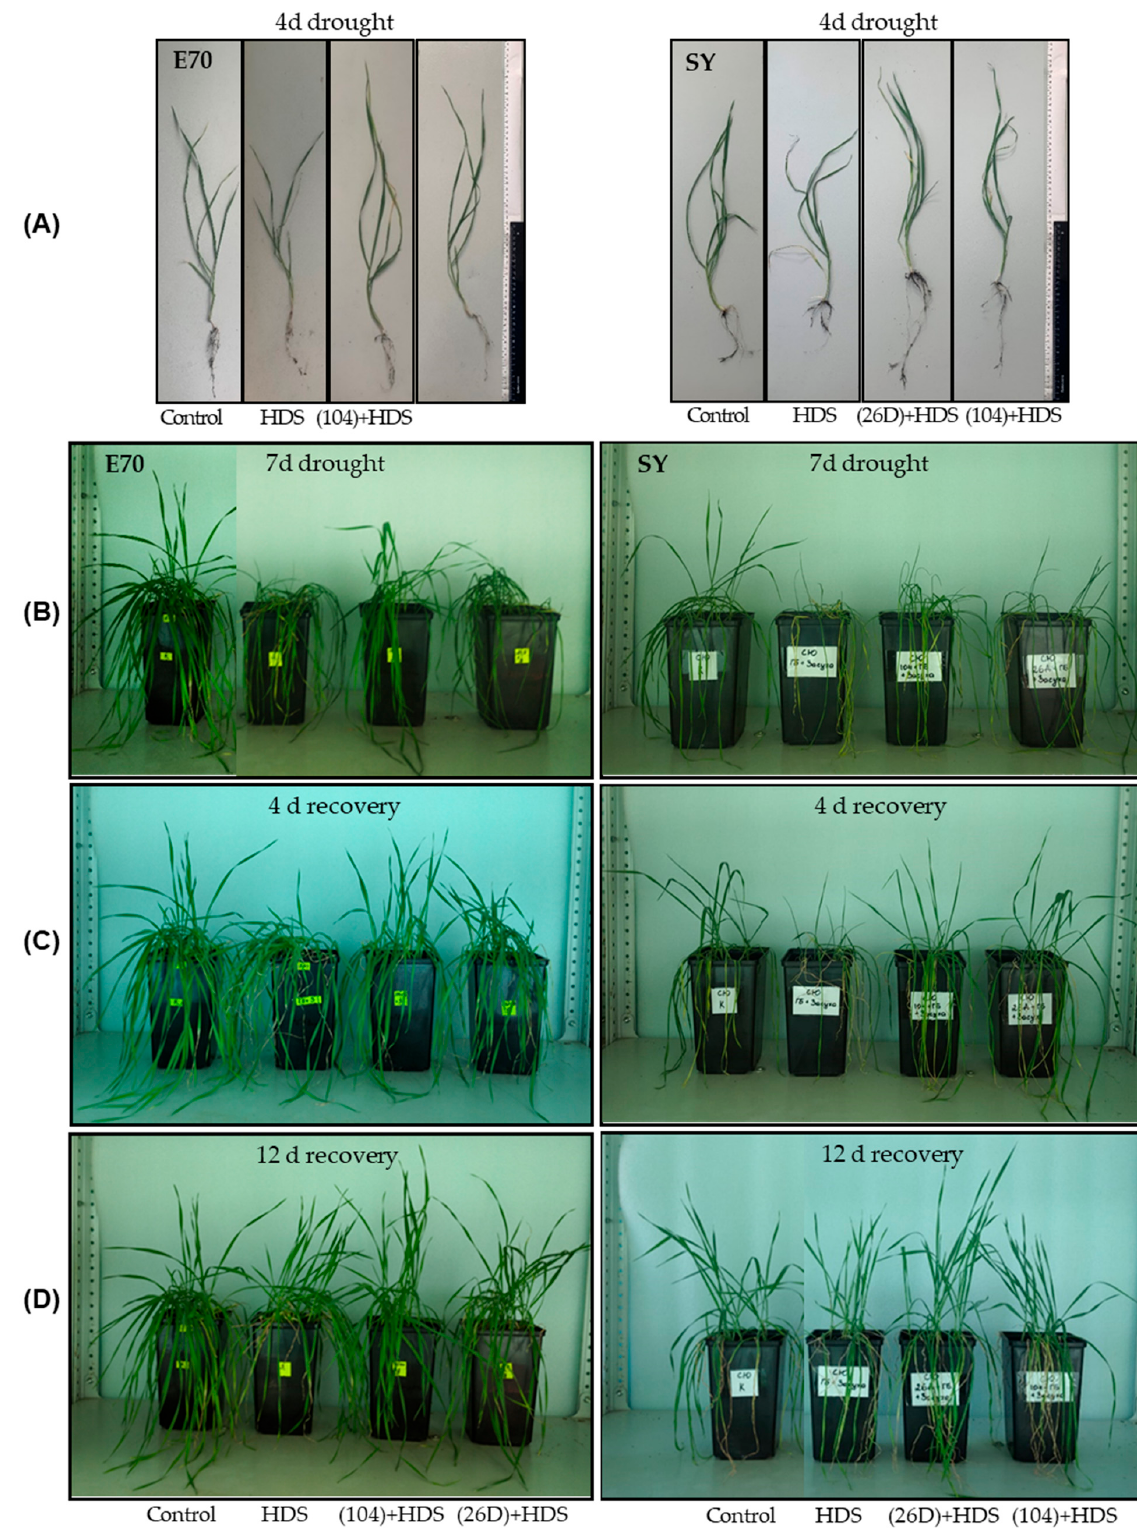
Figure 5. Influence of B. subtilis 104 and 26D on the phenotypic characteristics of wheat plants of varieties E70 and SY sprayed with herbicide Sekator ® Turbo and exposed to soil drought for 4 and 7 days with the subsequent resumption of normal irrigation. ( A ) 4 days of drought exposure; ( B ) 7 days of drought exposure; ( C ) 4 days of recovery after resumption of normal irrigation, ( D ) 12 days of recovery.